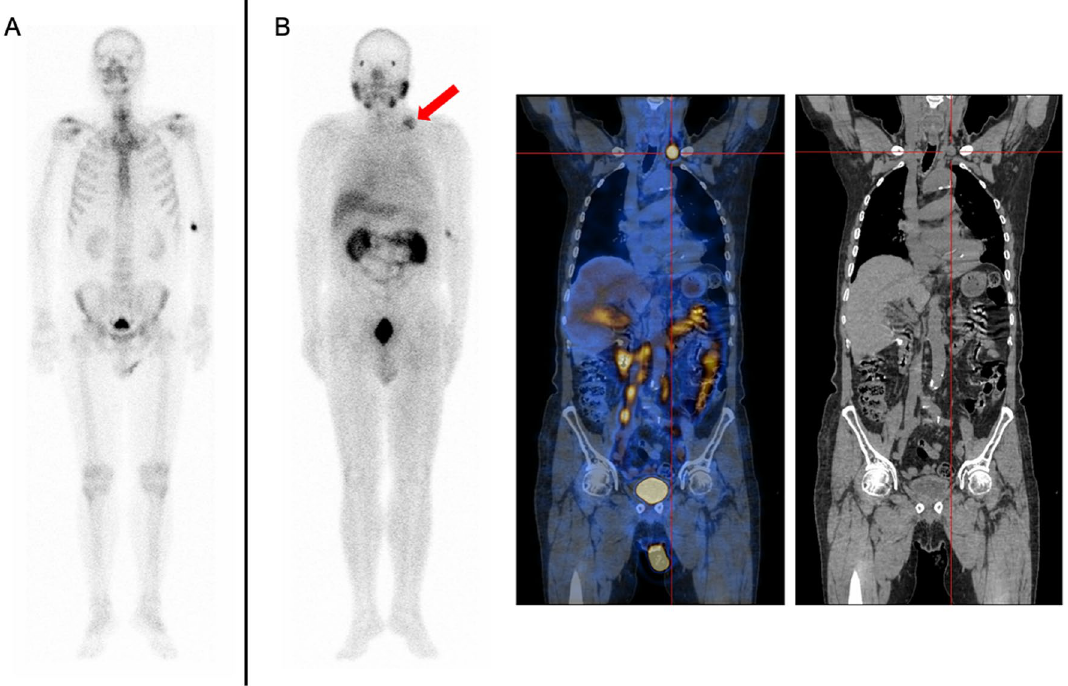
Figure 7. A 67-year-old patient with a restaged PCa. The Gleason score was 10, and the PSA level was 0.11 ng/ mL; ( A ): Whole-body planar 99m Tc-MDP. ( B ): Whole-body planar 99m Tc-PSMA and coronal SPECT/CT. 99m Tc- PSMA SPECT/CT revealed lymph node metastases in the left supraclavicular fossa (B, red arrow and